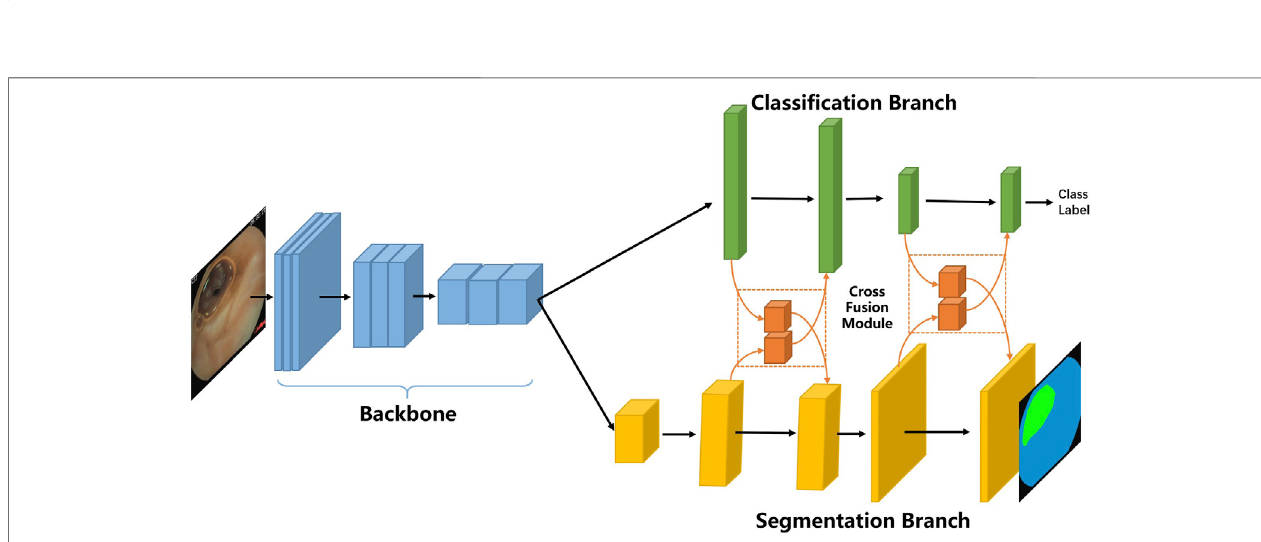
FIGURE 1 | Evolution routing map of the multi-task network structure. Blue rectangles represent the shared layers, like the backbone. Green and yellow ones denote the different task branches. The orange block is the cross fusion module introduced by us in this work.